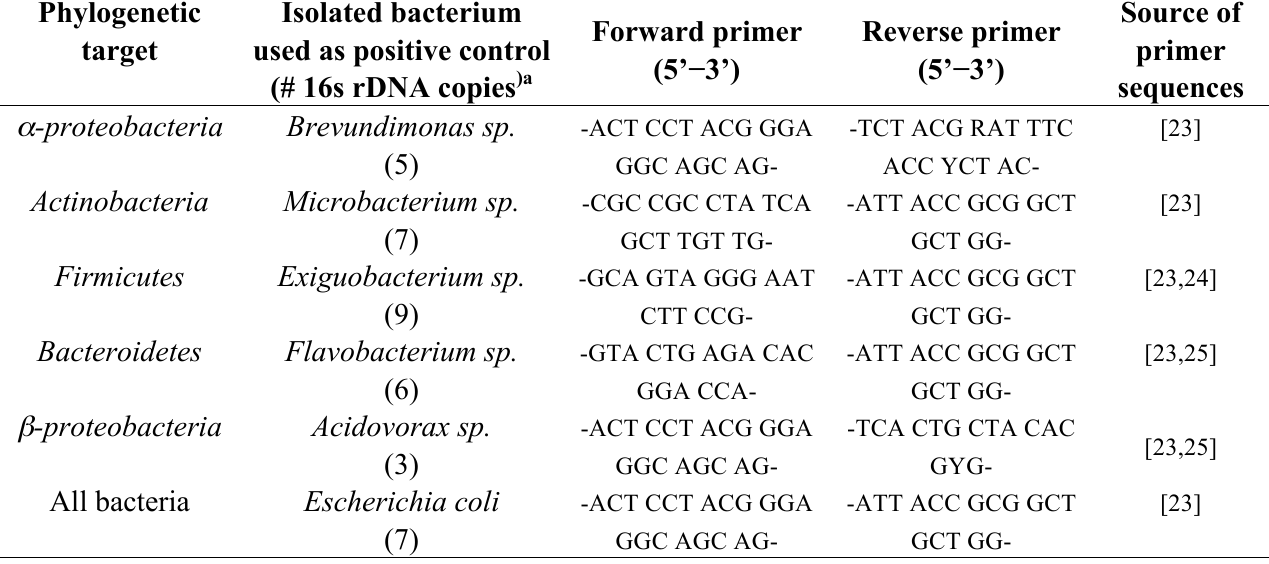
Table 1. Group specific primers used for the qPCR